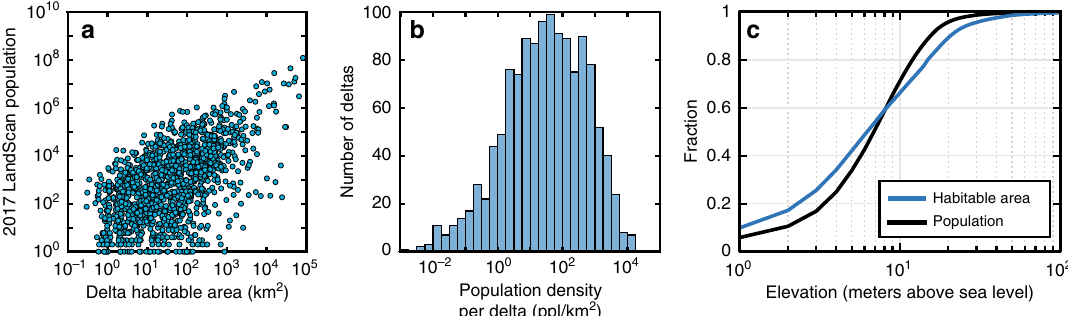
Fig. 2 Statistics of delta area and population. a Population scales with habitable area. Each dot represents a single delta ( n = 1652). There are 522 deltas either with no measurable population or habitable area; b Histogram of deltaic population density calculated as the total population for each delta relative to the habitable area ( n = 1652). c Cumulative distribution function of habitable area and population as a function of elevation. Distribution only includes deltaic pixels with an elevation of 100 m or less, which accounts for 99.7% and 99.9% of the total habitable area and population,